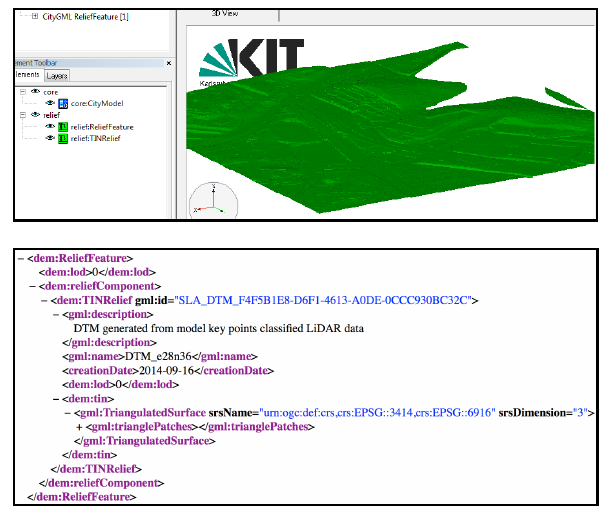
Figure 5. Relief as LOD 0 triangulate surfaces